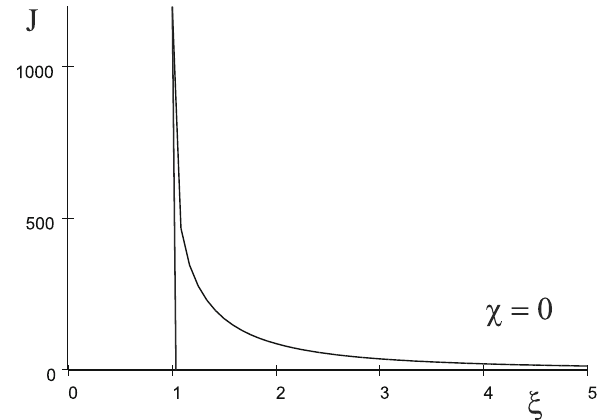
Fig. 1 The plot of J (ξ, 0 ) which corresponds to the scattering on nor- mal matter. All the tail lies in the retarded region ξ > 1. Tails in the case χ (cid:7) 1 have similar form but contain an advanced part